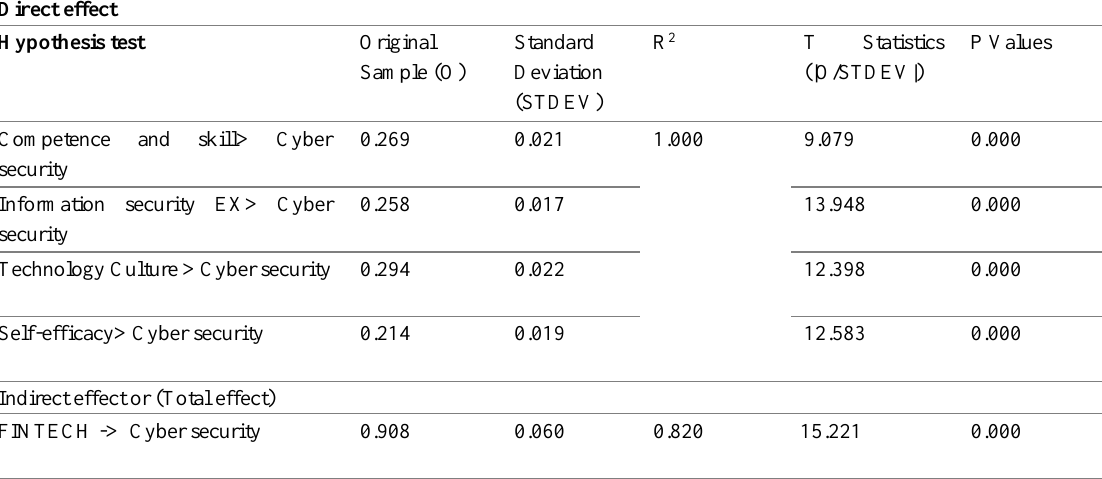
Figure 2: simple direct regression analysis the model variables Table 4: Analysis of simple direct and indirect regression between the model